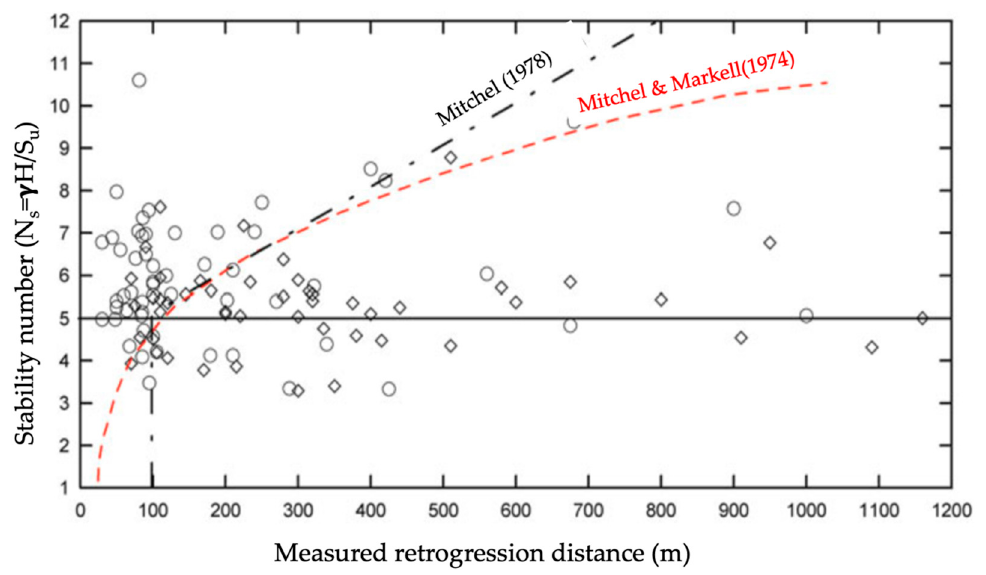
Figure 4. Retrogression distance as a function of the stability number for historical cases (circles) and ancient scars (diamonds) [11].